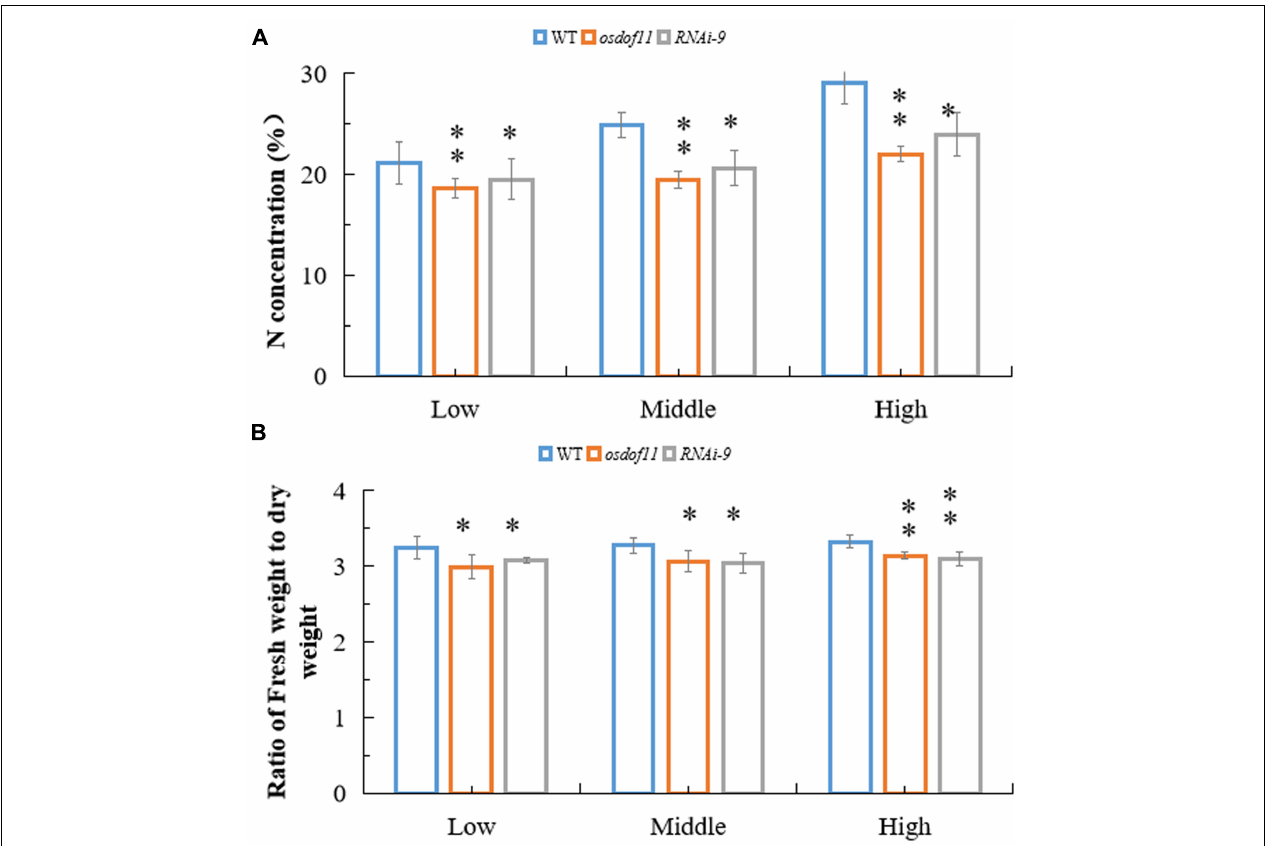
FIGURE 2 | OsDOF11 affects nitrogen metabolism by sugar distribution in the effective leaf blade at the flowering stage. (A) Ratio of fresh weight to dry weight of effective leaf blade at flowering stage; (B ) N concentration in effective leaf blade at flowering stage; Low: treatment by urea 90 kg/hm 2 ; Mid: treatment by urea 135 kg/hm 2 ; High: treatment by urea 180 kg/hm 2 . Error bars represent SE of at least five samples. * P < 0.05; ** P <